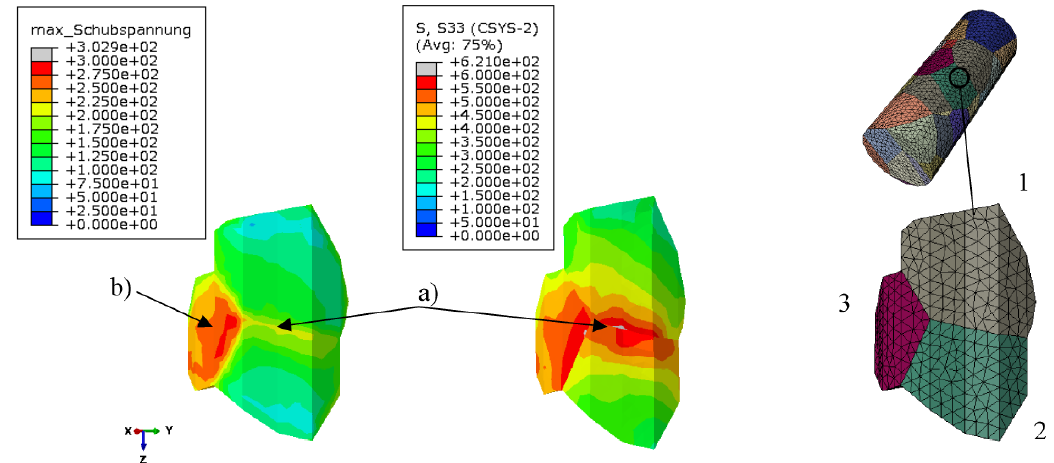
Figure 12. Distribution of maximum resolved shear stress at free cut grains in the [111] (110) slip systems for globally applied strain of 0.25%.